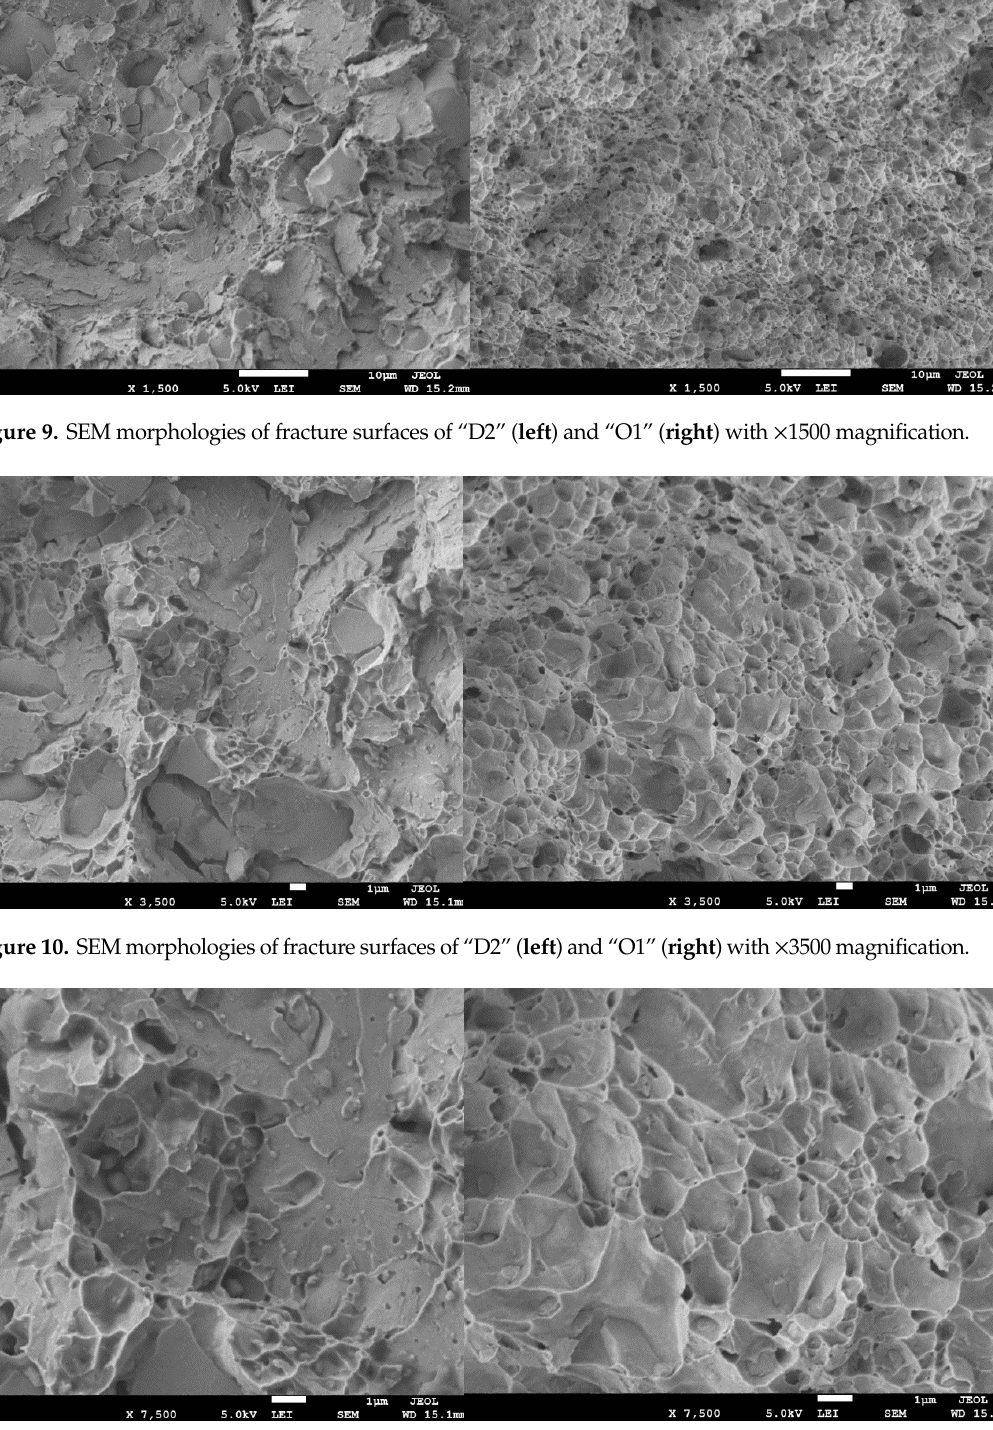
Figure 11. SEM morphologies of fracture surfaces of “D2” ( left ) and “O1” ( right ) with ×7500 magnification.